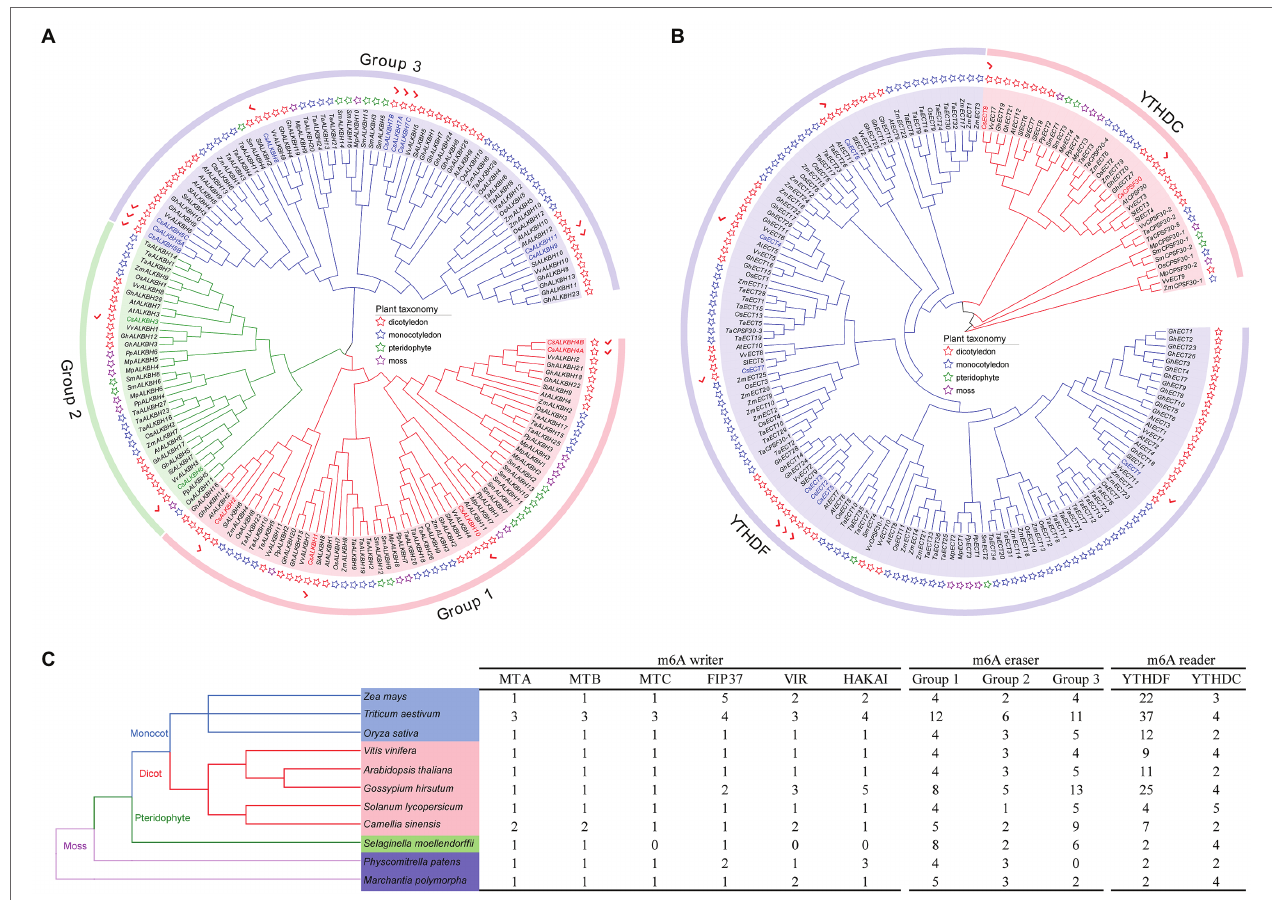
FIGURE 2 | Evolutionary analysis of m6A regulatory genes from five dicotyledons, three monocotyledons, one pteridophyte, and two mosses. (A) Phylogenetic tree of m6A eraser genes. (B) Phylogenetic tree of m6A reader genes. (C) Number of m6A regulatory genes in different plant